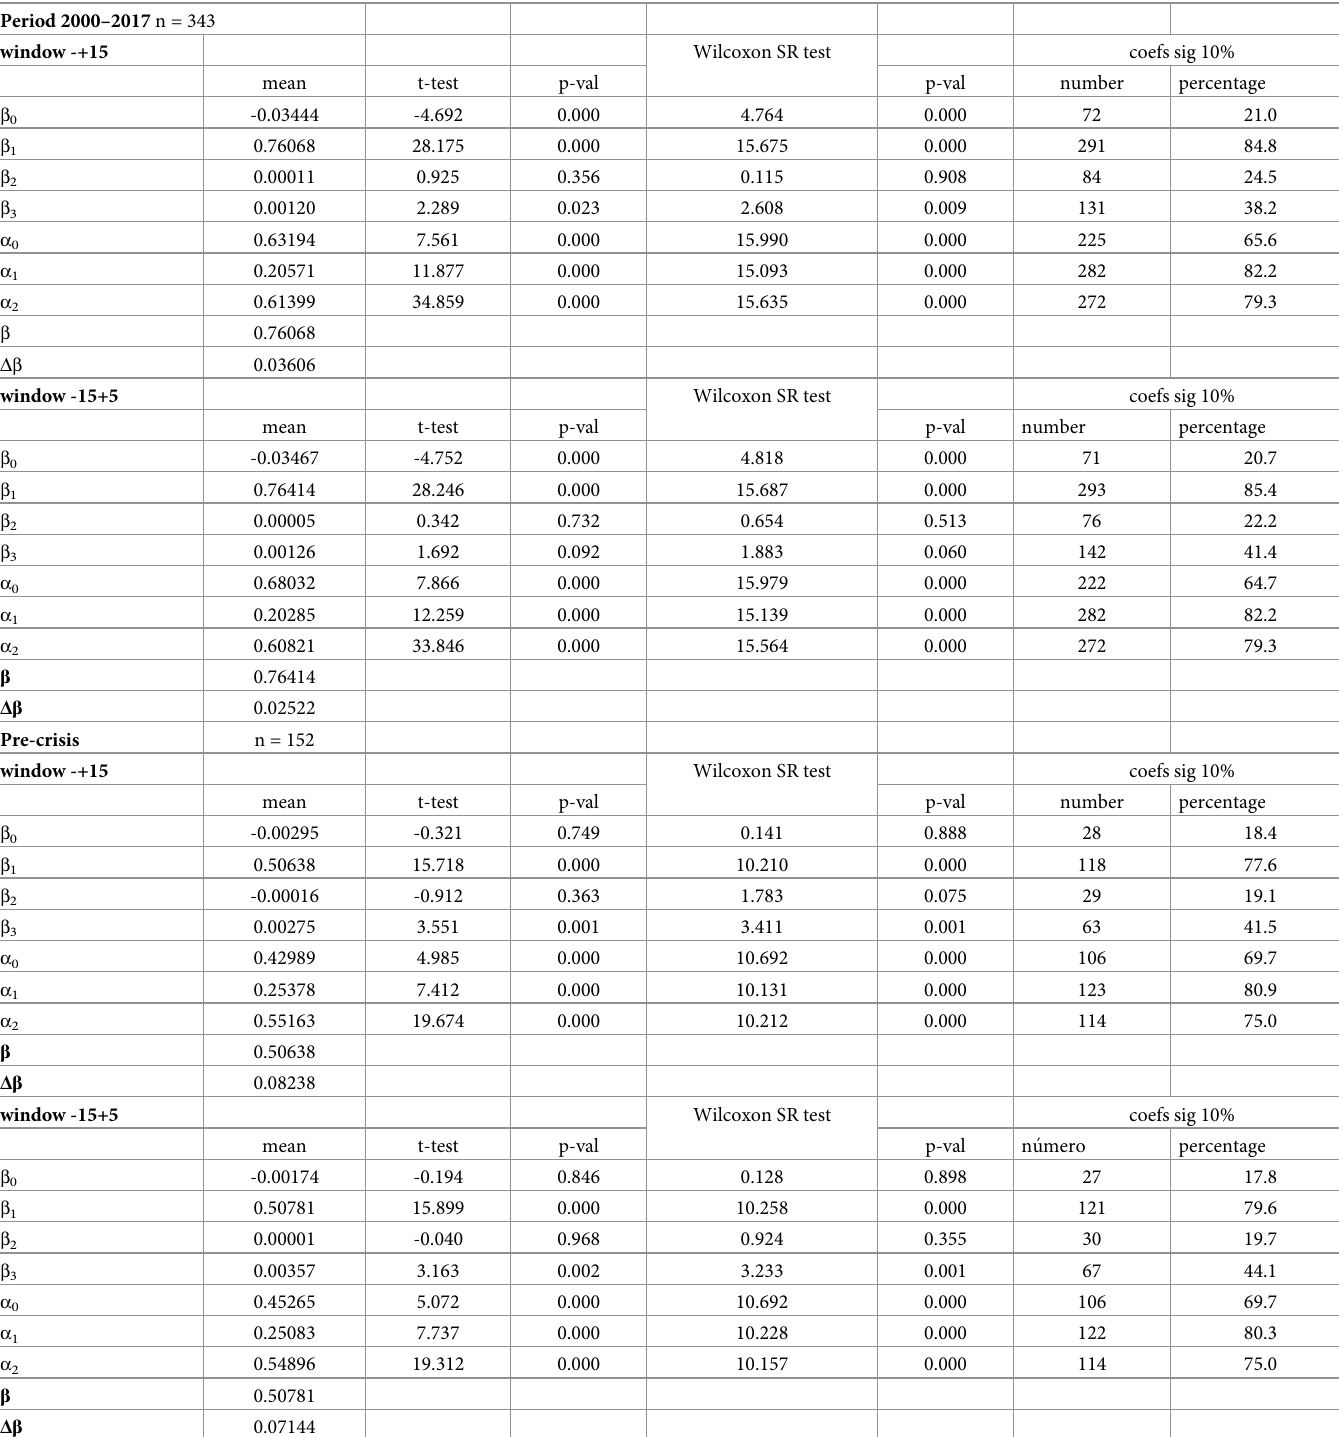
Table 5. Summary results: